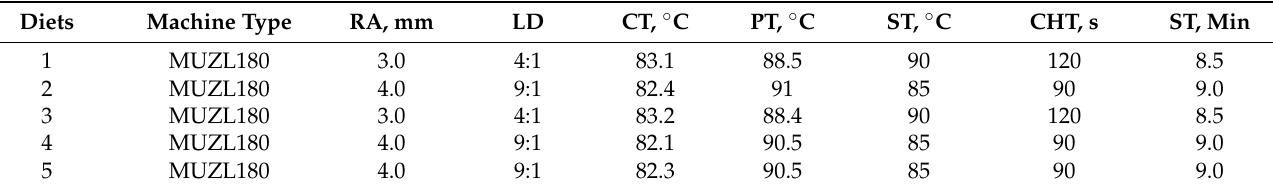
Table 3. Pelleting parameters of experimental